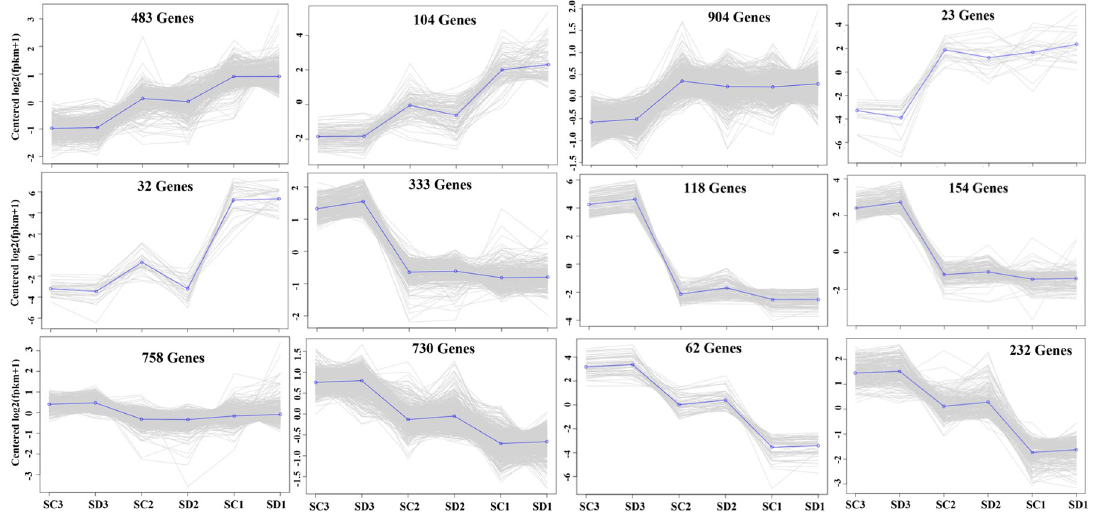
Fig 4. Twelve groups of gene co-expression trend of differentially expressed genes (DEGs) among three stages of flower bud development.